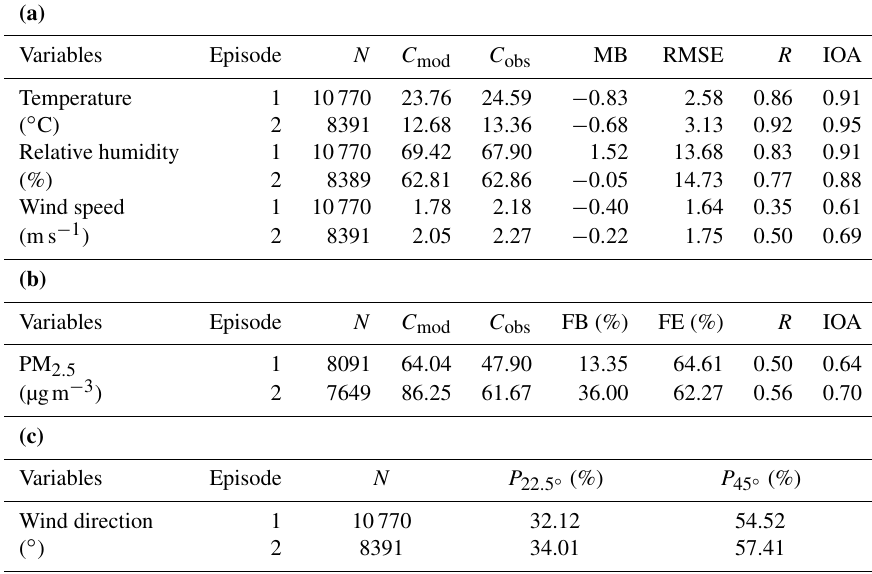
N is the total number of samples. C mod and C obs are the average value of modeled and observed results, respectively. MB and FB are the mean and fractional bias, respectively. RMSE and FE are the root-mean-square and fractional error, respectively. IOA is the index of agreement. R is the correlation coefficient between the observed and simulated results. P 22 . 5 ◦ and P 45 ◦ represent the proportions of compared results that the absolute biases between the simulated and measured wind directions are within 22.5 and 45 ◦ ,